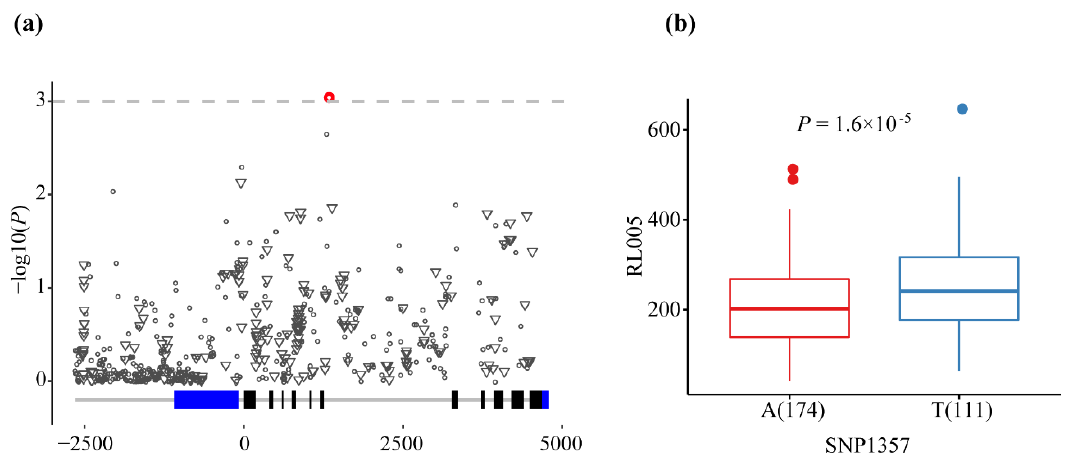
Figure 5. Natural variations in ZmMADS60 were significantly associated with root length between 0 mm and 0.5 mm in diameter (RL005). ( a ) ZmMADS60 -based association mapping for RL005, a schematic diagram of the genomic region of ZmMADS60 , including upstream sequence and introns ( light gray ), the coding region ( black ), and 5'UTR and 3'UTR ( blue ) is presented. ( b ) Comparison of RL005 between different alleles of SNP1357.